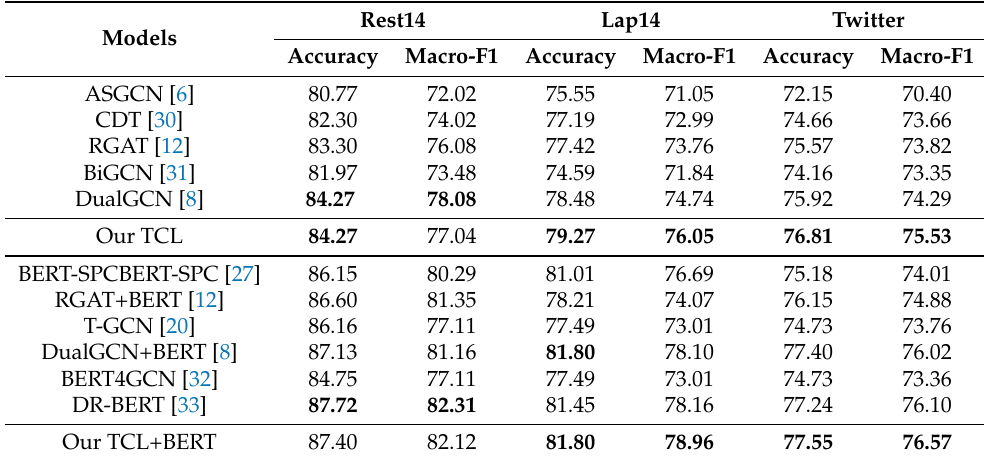
Table 2. Experimental results. Bold numbers represent the best results among methods of the same type. Rest14 Lap14 Models